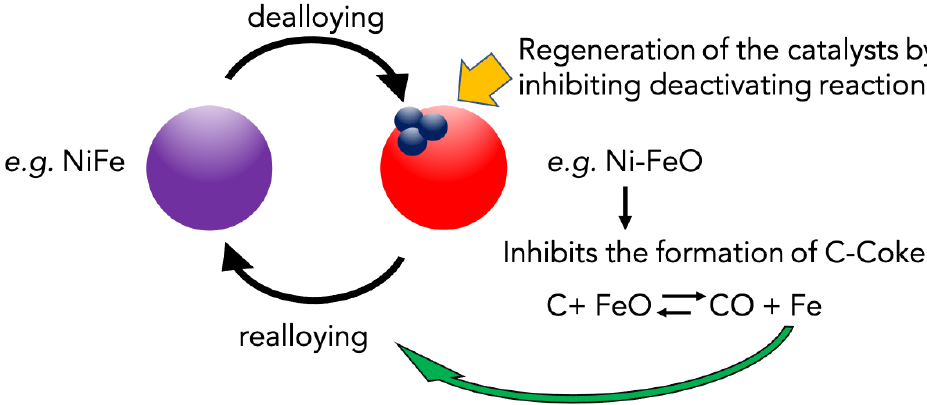
Figure 3. Example of self-regulating phase-change catalyst. See the main text and [42] for